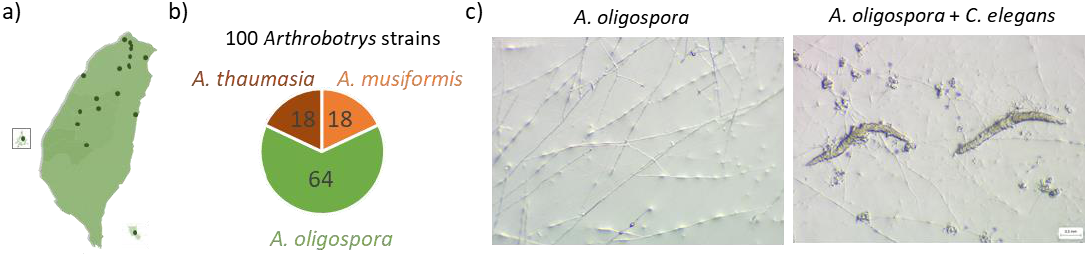
Figure 1. A large-scale collection of 100 strains of nematode-trapping fungi of Arthrobotrys genus in Taiwan. ( a ) The locations of which the nematode-trapping fungi were isolated in Taiwan. ( b ) The collection of 100 strains of nematode-trapping fungi of Arthrobotrys genus, including 18 strains of A. thaumasia , 18 strains of A. musiformis , and 64 strains of A. oligospora . ( c ) The nematode-trapping fungi in the saprophytic stage (left) and in the predatory stage